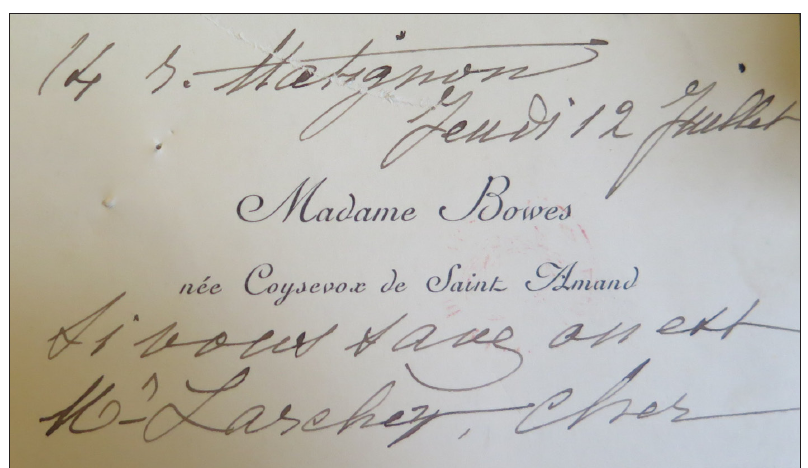
Fig. 2 : Calling card of Alphonsine Bowes de Saint-Amand, c. 1900, Bibliothèque nationale de France, Bibliothèque de l’Arsenal, Papiers Lorédan Larchey, MS